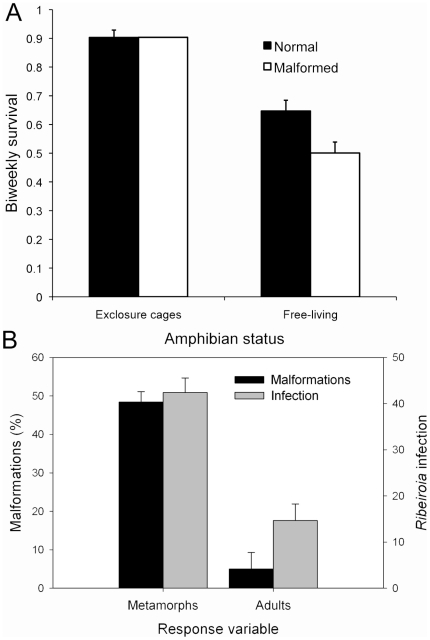
Survival, malformations, and infection data from Pacific chorus frogs (P. regilla) in nature.(A) Estimated biweekly survival of normal and malformed frogs as a function of whether they were free-living or maintained within predator-free exclosures. Survival estimates of free-living frogs were determined using MARK over the course of sampling events, whereas the survival of frogs in two replicate cages on the shore of a pond were estimated over 33 days and back-calculated to biweekly survival using an exponential decay function. (B) Malformation frequency and Ribeiroia infection intensity in metamorphic and adult frogs from Sheep Pond. Presented are the mean infection intensity + 1 SE and the overall malformation frequency with the 95% upper confidence interval for a proportion.